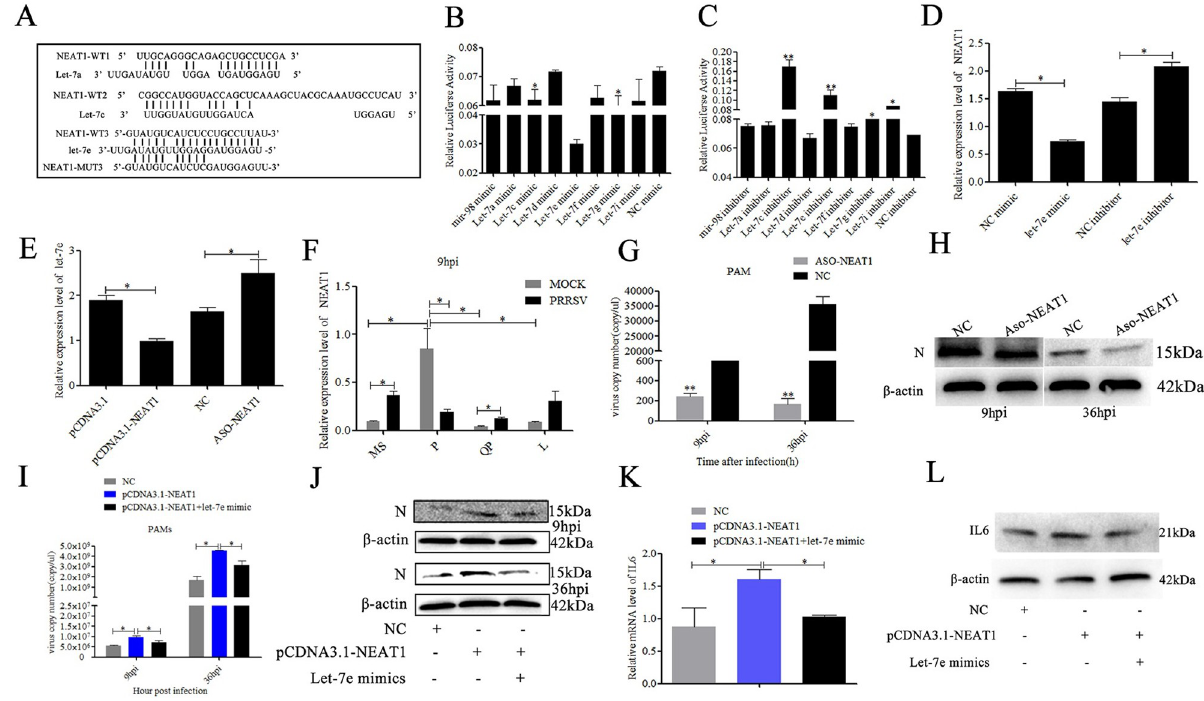
Fig 4. LncRNA NEAT1 could inter-regulate with let-7 and PRRSV-2. The let-7 binding sites in NEAT1 were predicted (A). Luciferase activity was analyzed in Marc-145 cells co-transfected with NEAT1-WT1, NEAT1-WT2 or NEAT1-WT3 reporter constructs as indicated and either corresponding Let-7 mimics (B) or Let-7 inhibitor (C). NEAT1 and let-7e regulate each other (D, E). Expression levels of NEAT1 were analyzed between PRRSV- infected and mock-infected PAMs from 4 pig breeds at 9 hpi by RT-qPCR (F). PAMs were transfected with ASO-NEAT1, pcDNA3.1-NEAT1, pcDNA3.1-NEAT1+let-7e mimics or corresponding negative control (NC), and then infected with PRRSV (MOI = 0.1). The cells were harvested at 9 h and 36 h post PRRSV-2 infection. The virus copy number was quantified by absolute quantitative PCR (G, I) and PRRSV-2 N protein was analyzed by Western blot (H, J), and the expression of IL6 was detected by RT-qPCR (K) and Western blot (L). Three independent experiments were carried out. Error bars stand for the mean ± SD of at least triplicate experiments, � p < 0 . 05 , �� p < 0 . 01 .